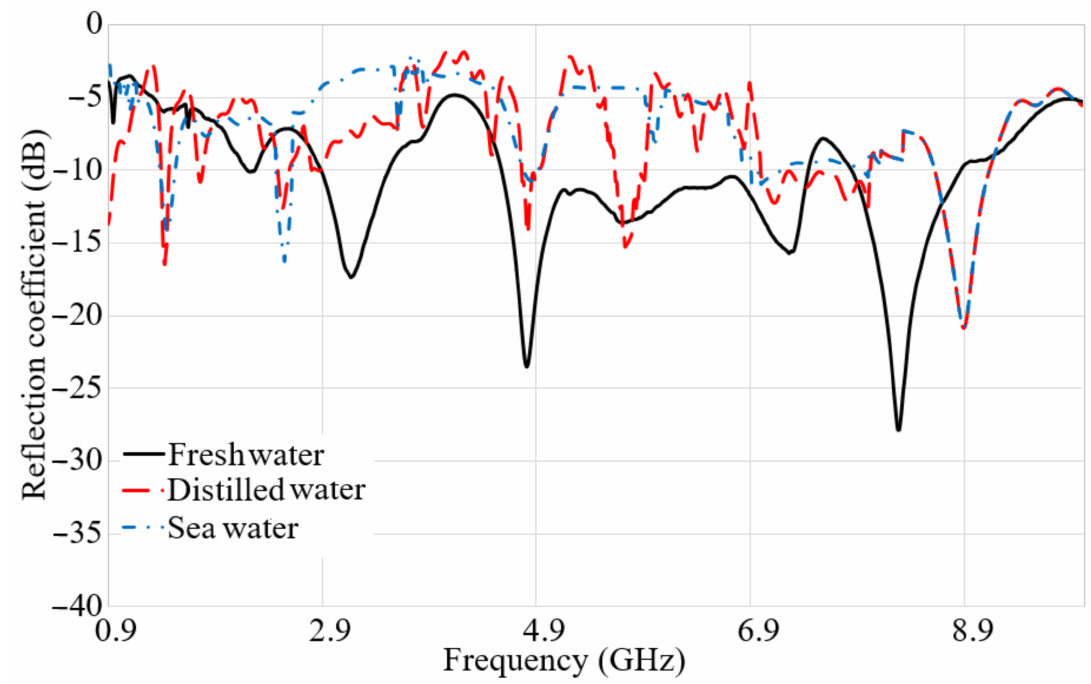
Figure 10. Measured S 11 result in fresh water, distilled water, and sea water.